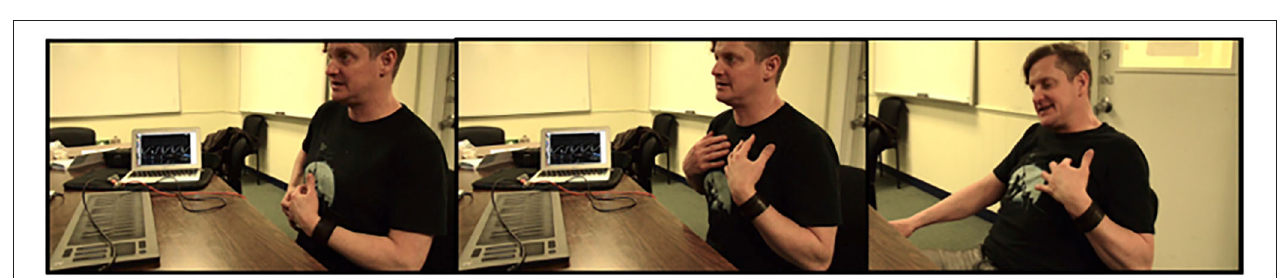
Figure 5 features snapshots from the video recording 12 of Black’s performance test of the first TIZI prototype at CIRMMT on